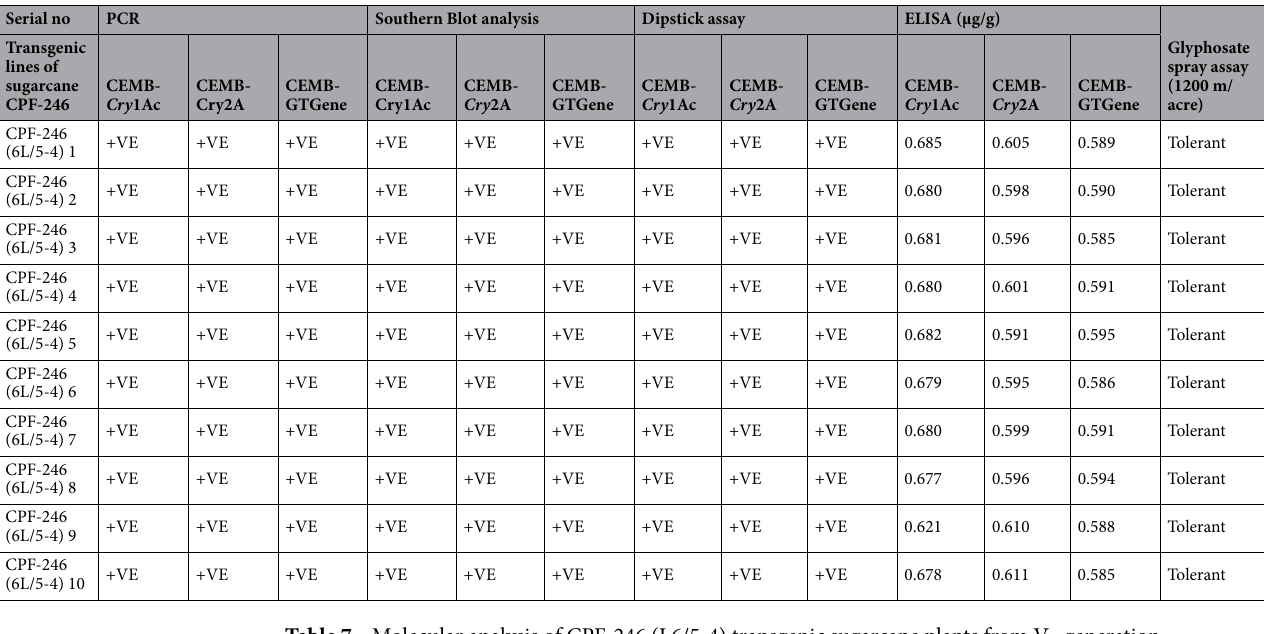
Table 7. Molecular analysis of CPF-246 (L6/5-4) transgenic sugarcane plants from V 2 -generation.